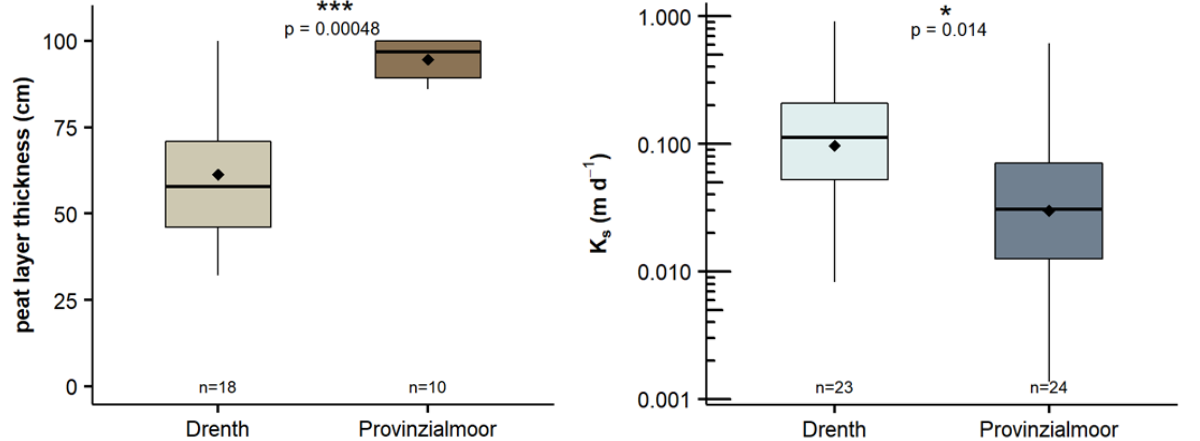
Figure 3. Comparison of the peat layer thickness (cm) at the sites Drenth and Provinzialmoor. Boxplots are showing median (central thick lines), 25 % and 75 % quartile ranges around the median (box length), outliers (circles) and mean values (rhomb); stars indicate the level of significance; n: number of samples.